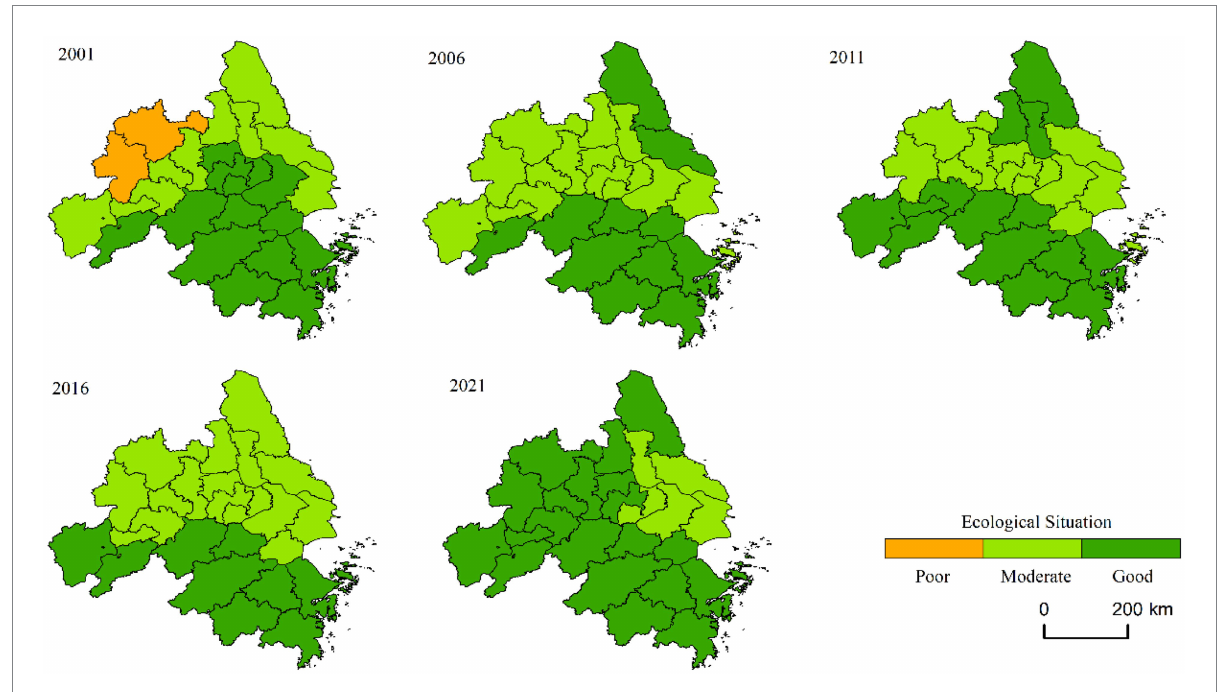
FIGURE 6 Changes in ecological environment quality of cities in Yangtze River Delta Urban